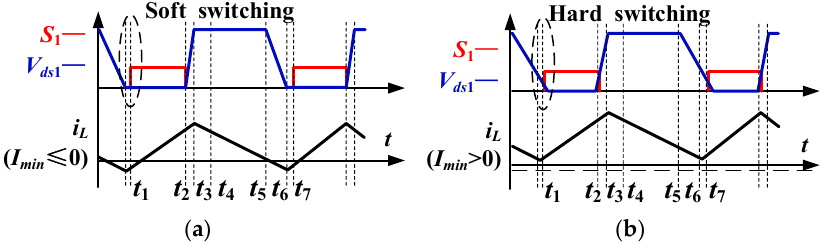
Figure 2. Waveforms of bidirectional converter with two conditions ( a ) I min ≤ 0 (with ZVS) and ( b ) I min > 0 (without ZVS).